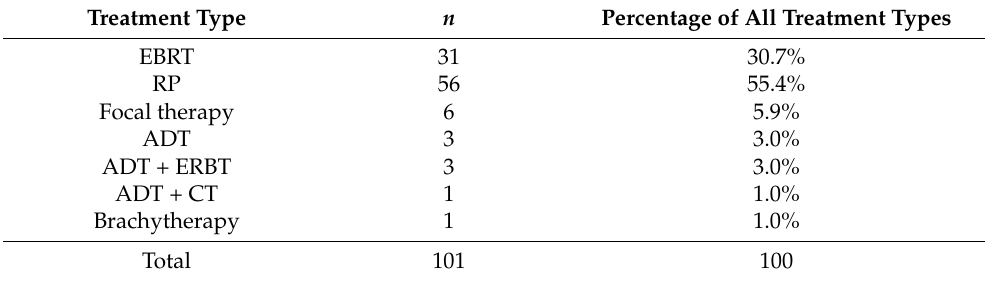
Figure 1. Probability of staying in active surveillance and probability of discontinuing active surveillance. Table 4. Treatment types after